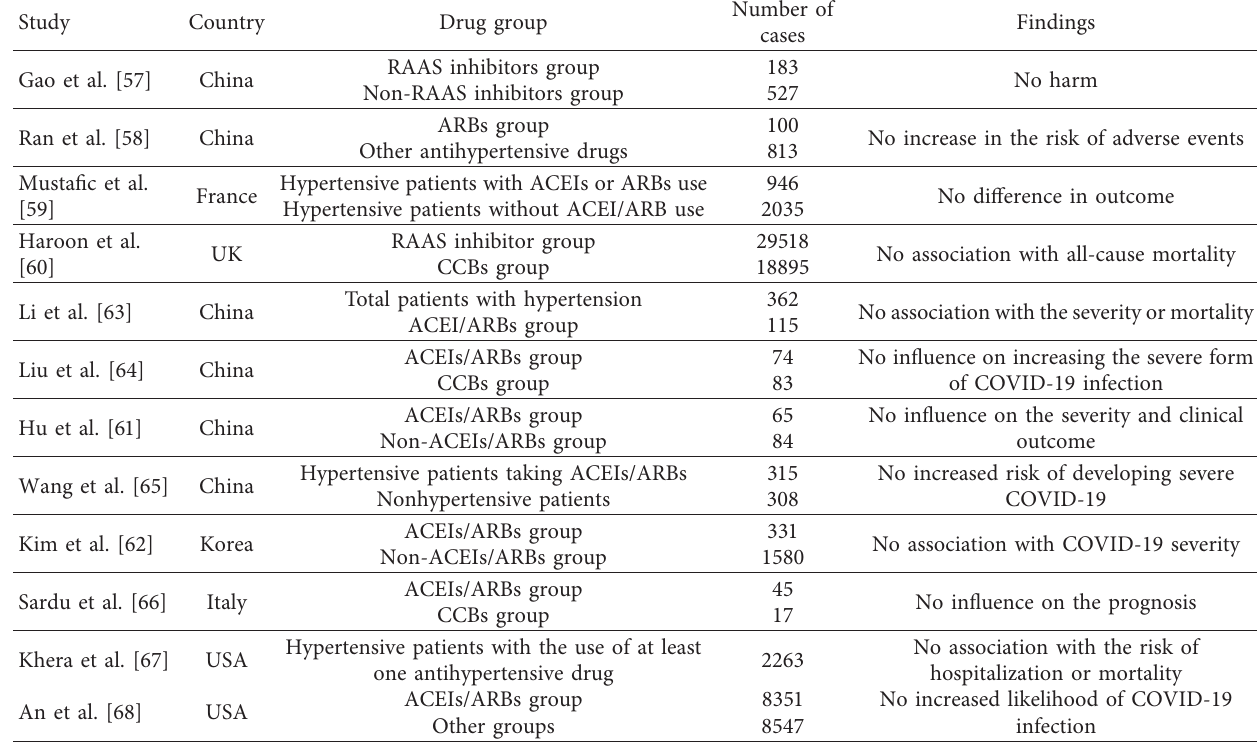
Table 1: Studies that showed neutral effects of ACEIs/ARBs on COVID-19 in hypertensive patients.